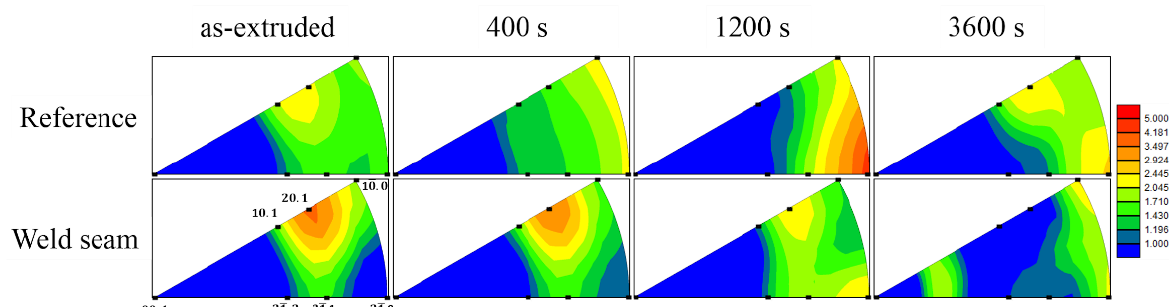
Figure 7. Texture evolution of the recrystallized partition of grains with increasing dwell time. IPF is parallel to the ED reconstructed from EBSD data presented in Figures 4 and 5. IPFs of both reference and weld seam material of profiles with an ER of 8:1 are